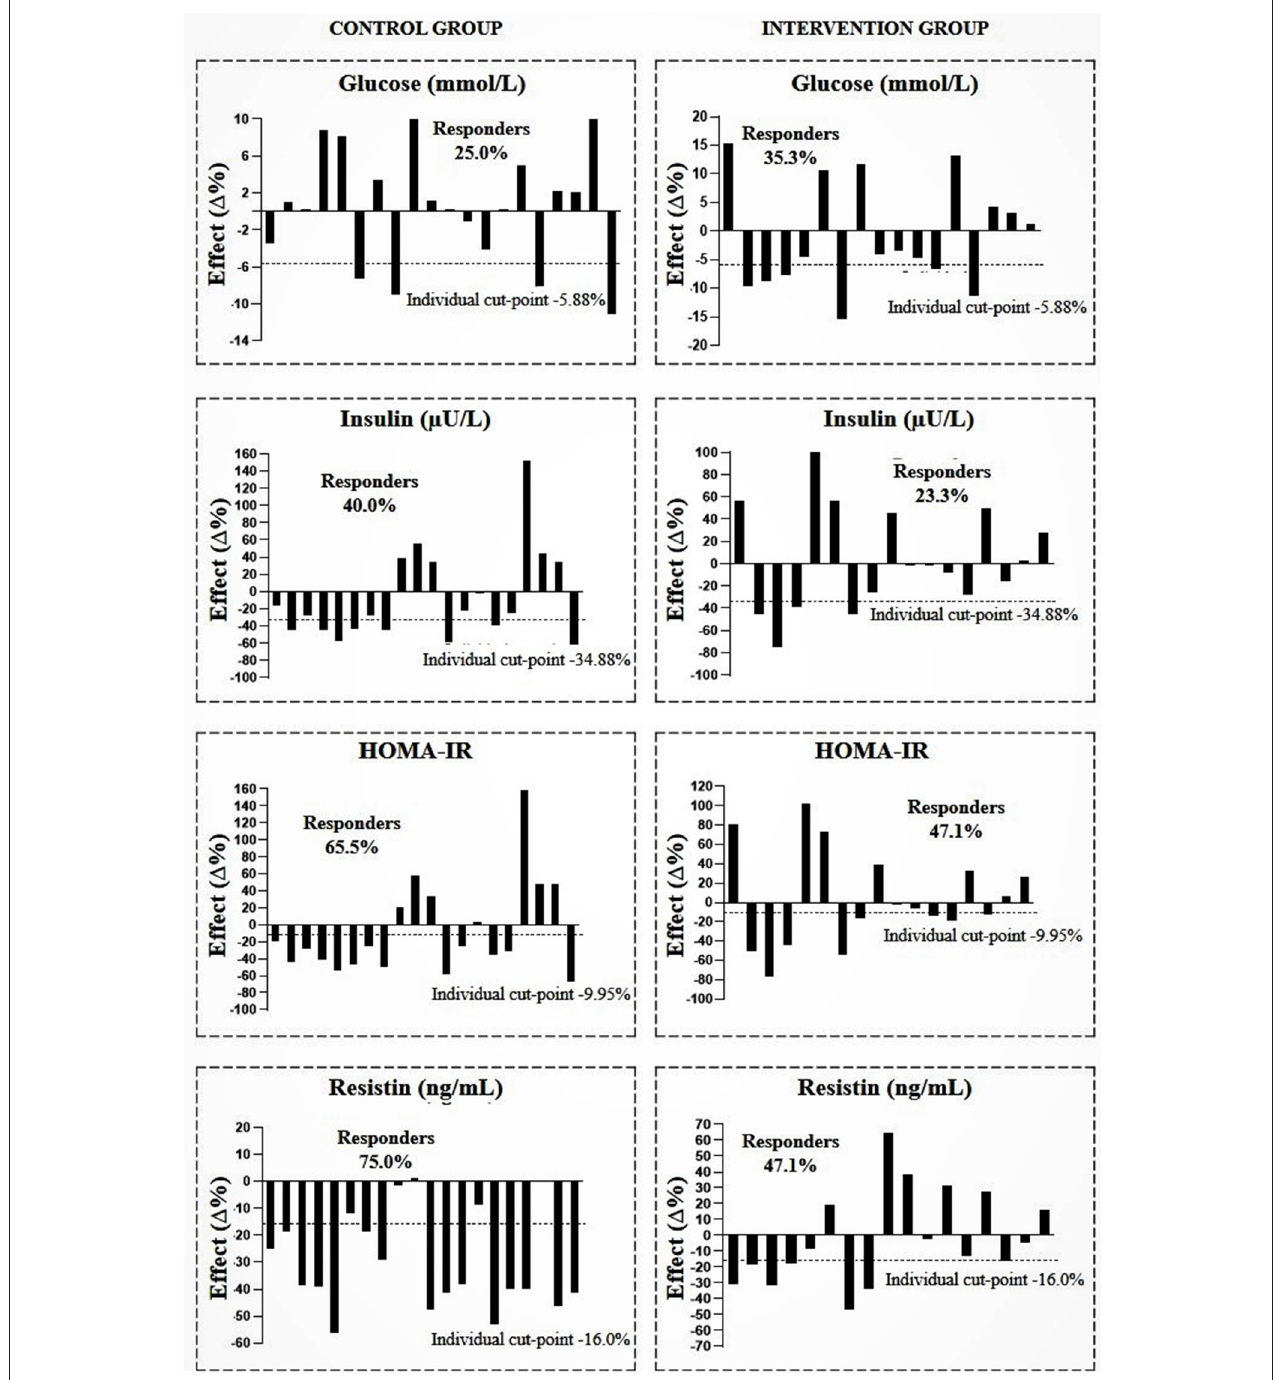
FIGURE 4 | Prevalence of responders in the intervention and control group after multicomponent intervention for glucose, insulin, homeostasis model assessment of insulin resistance (HOMA-IR), and resistin. CG, n = 20; IG, n = 17. The analyses were adjusted for sex, age, and sexual maturation.